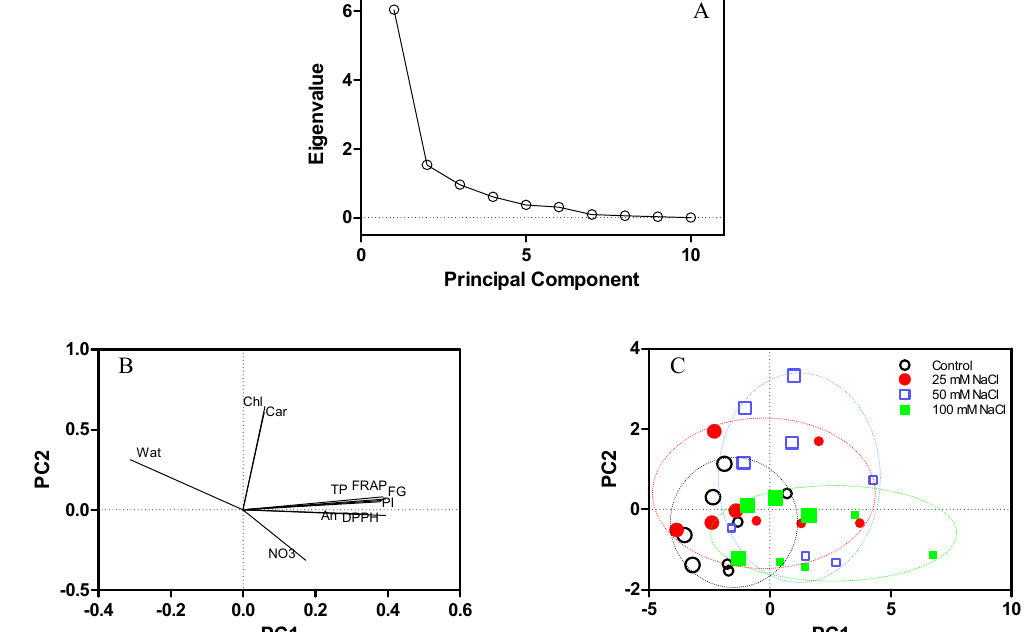
Figure 4. Principal Component Analysis (PCA) for quality parameters of fresh leaf tissues of Reichardia picroides plants grown in floating system with different NaCl concentrations in the nutrient solution (1.7, control; 25; 50; 100 mM) and sampled four and six weeks after transplanting. ( A ): scree plot; ( B ): plot of component weights (water content, Wat; total chlorophylls, Chl; carotenoids, Car; flavonol glycosides, FG; total phenols, TP; phenol index, PI; ferric reducing antioxidant power, FRAP; 2,2-diphenyl-1-picrylhydrazyl radical scavenging activity, DPPH; anthocyanins, An; nitrates, NO 3 ); ( C ): scatterplot of data obtained after the first (large symbols) and second (small symbols) sampling.